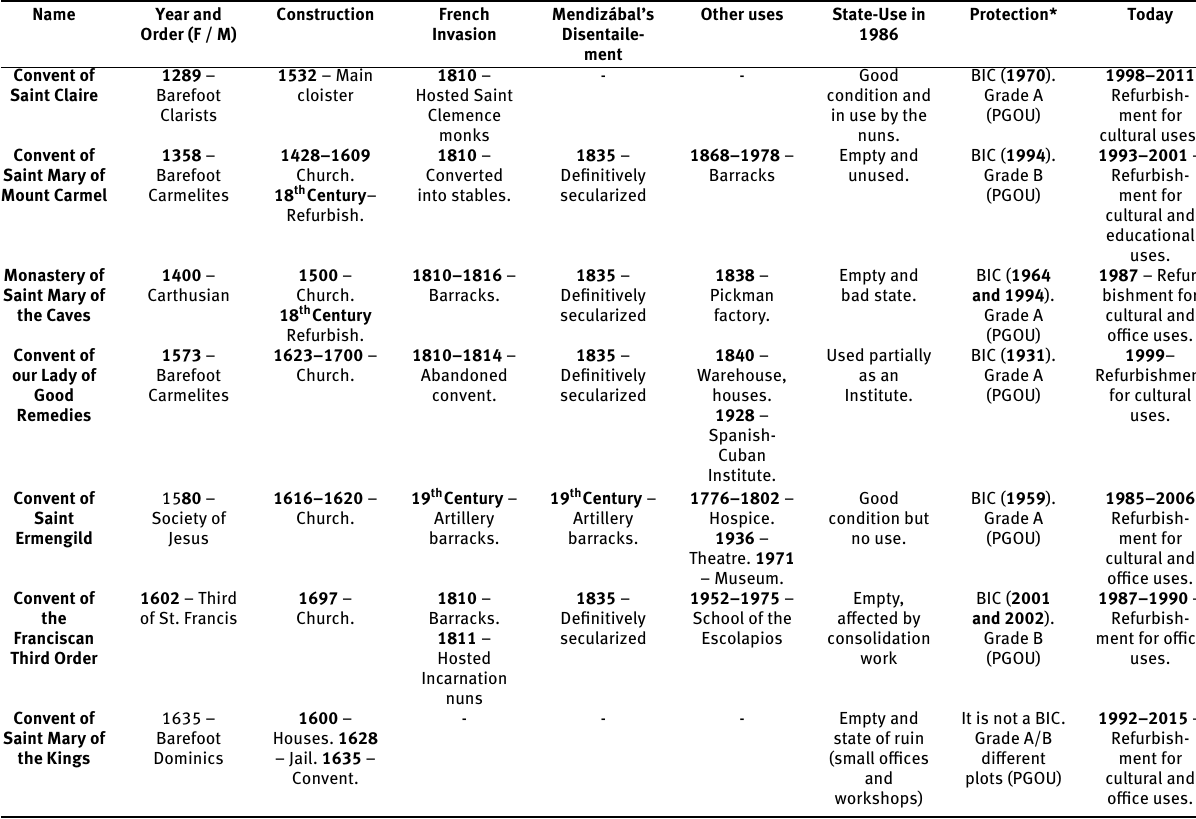
Table 1: Summary of transformations of the 7 selected